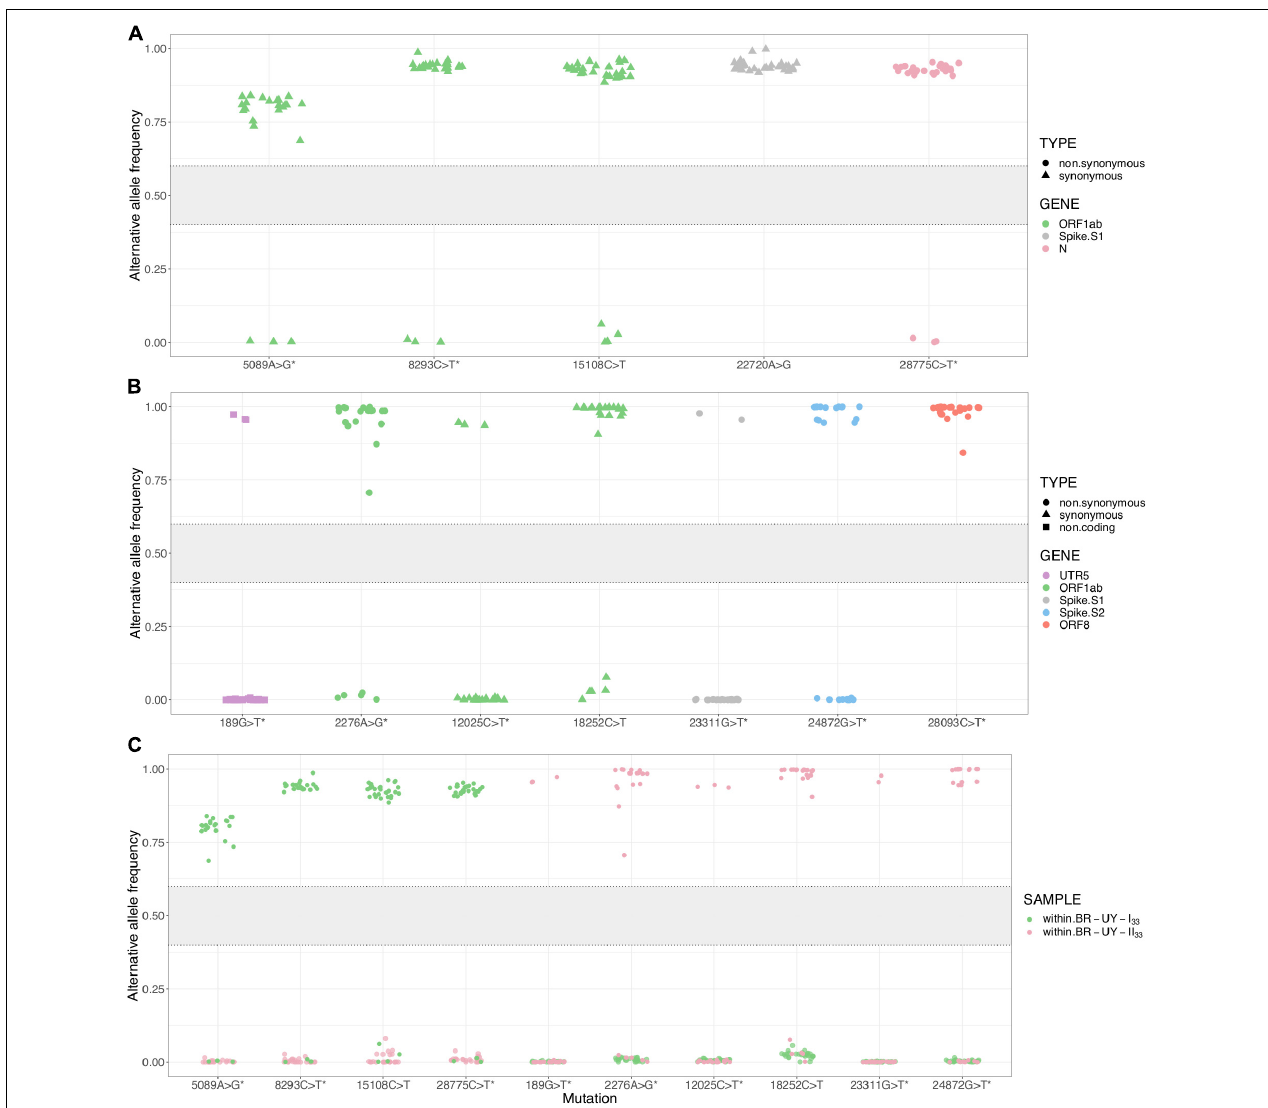
FIGURE 5 | Within-host diversity in synapomorphic sites for the SARS-CoV-2 clades BR-UY-I 33 and BR-UY-II 33 . (A) Alternative allele frequencies for the clade BR-UY-I 33 , as observed from trimmed bam files. Positions and annotations follow Wuhan’s reference sequence MN908947.3; corresponding gene annotation and mutation types are indicated by color and shape, respectively. The asterisks indicate the synapomorphic sites where the MUTATION explanatory variable shows a significant coefficient in the implemented linear model ( p -value ≤ 0.05). In other words, the allele frequencies for these sites are robust to sequencing technology. (B) Same as (A) , but for the clade BR-UY-II 33 . For both clades, the absence of alleles with intermediate frequencies (0.4 < f < 0.6) is notorious. (C) Alternative allele frequencies for all synapomorphies within both BR-UY-I 33 and BR-UY-II 33 clades. For each mutation, there is an overlap in the alternative allele frequencies of those samples that do not show the synapomorphy, regardless of the clade they belong to. The gray zone in the plot shows the intermediate allele frequency range (40–60%) as defined by Bull et al.